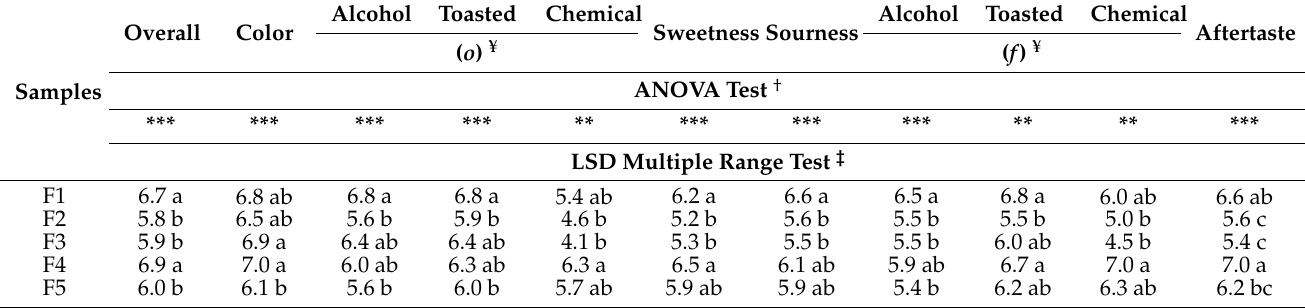
Table 2. Liking scores of Spanish consumers regarding the Fondill ó n samples under